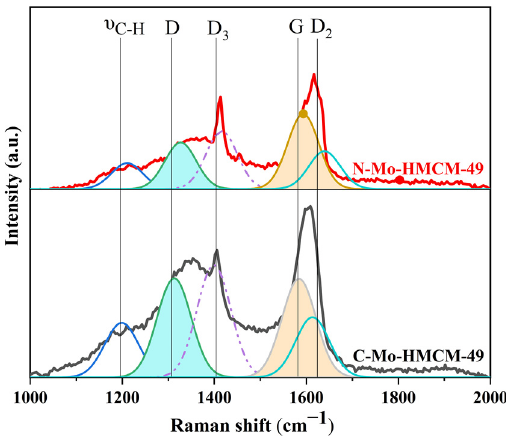
Figure 11. Raman spectra of the C-Mo-HMCM-49 and N-Mo-HMCM-49 catalysts after reaction under CH 4 flow at 700 °C for 430 min.